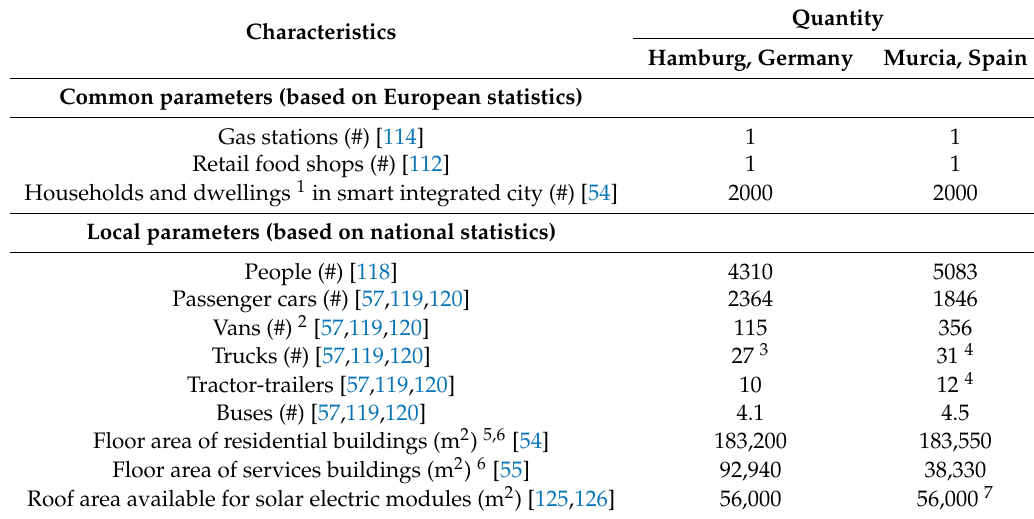
Table 2. Characteristics of the modeled smart city areas.